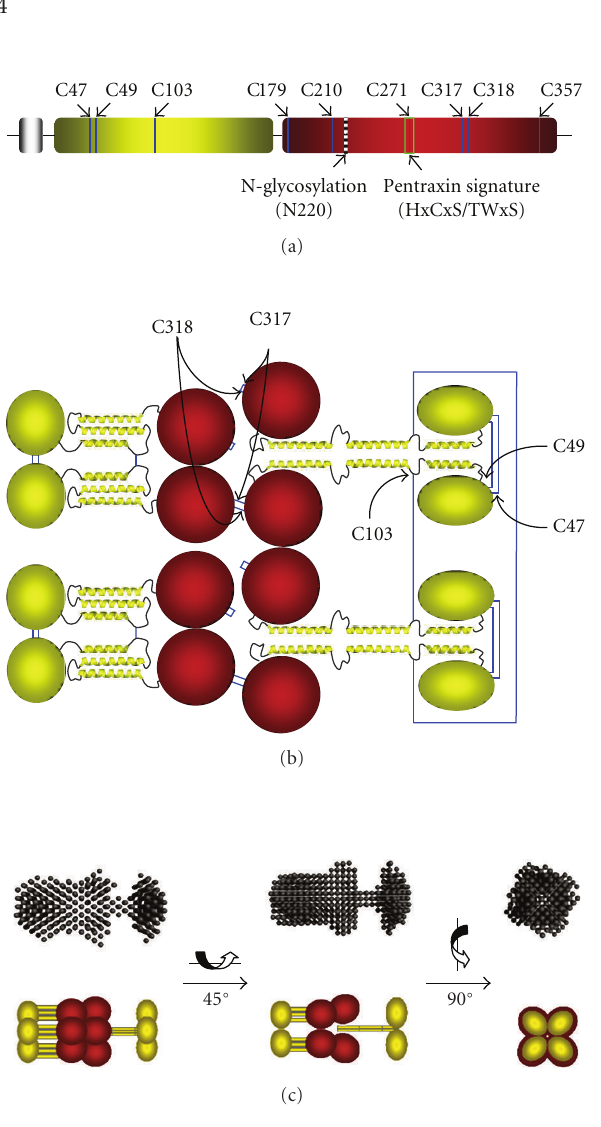
Figure 1: Model of the PTX3 octamer: arrangement of protomer subunits. (a) Schematic representation of the PTX3 protomer showing the N-terminal domain in yellow, followed by the globular pentraxin domain in red. Positions of the Cys residues, the N - glycosylation site at Asn220, and the pentraxin signature motif are indicated (see text for details). (b) Disulfide bond organization of the PTX3 octamer. The N-terminal domain (yellow) is comprised of an N-terminal segment followed by three α -helices (see text). The α -helical regions of the N-terminal domains, predicted to form coiled-coil-like structures, are hypothesized to adopt two distinct structural arrangements: either an extended conformation (right) in which four protomers associate through interchain interactions (i.e., to form tetramers) or a compact organization (left) where each protomer self-associates to form an antiparallel three-helix bundle (i.e., to form dimer of dimers). Cys317 and Cys318 in the C-terminal pentraxin domains (denoted in red) link the protomers (i.e., a tetramer and two dimers) into octamers. (c) A comparison of the SAXS envelope with a schematic model for PTX3-based on the two di ff erent organizations proposed for the N-terminal domain above; the α -helical segments of the N-terminal domain are depicted as yellow rods. The C-terminal pentraxin domains are in